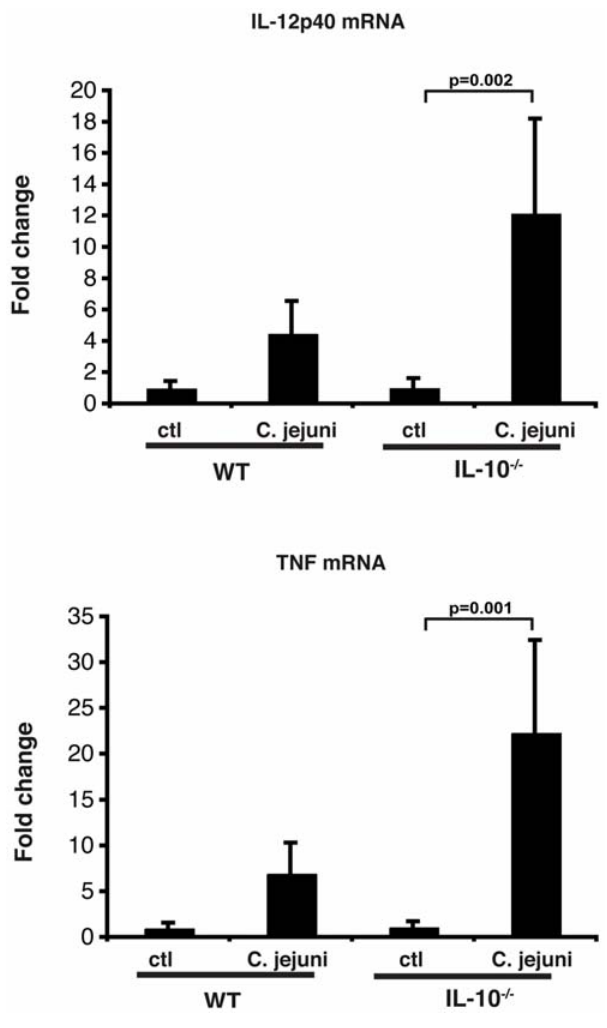
Figure 7. Increased TNF a and IL-12p40 mRNA accumulation in C.jejuni -associated IL-10 2 / 2 ; NF- k B EGFP mice. IL-10 wt/wt ; NF- k B EGFP and IL-10 2 / 2 ; NF- k B EGFP were associated with C. jejuni for 14 days. Colonic sections were lysed in trizol and RNA was extracted, reverse- transcribed (1 m g) and amplified by PCR using specific murine TNFa and IL12p40 primers. GAPDH was used as loading control. WT=IL-10 wt/wt ; NF- k B EGFP , n=7; KO=IL-10 2 / 2 ; NF- k B EGFP , n=7; WT C. jejuni associated: n=12; KO C. jejuni associated: n=10. (*p=0.002 for IL12p40 vs. control, *p=0.001 for TNF vs. control).